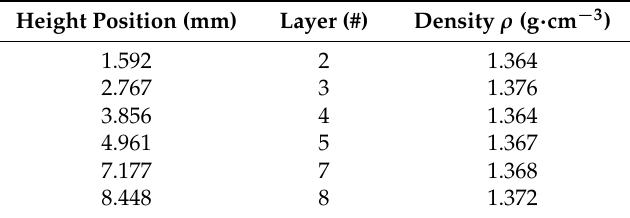
Table 3. Position and density of the individual